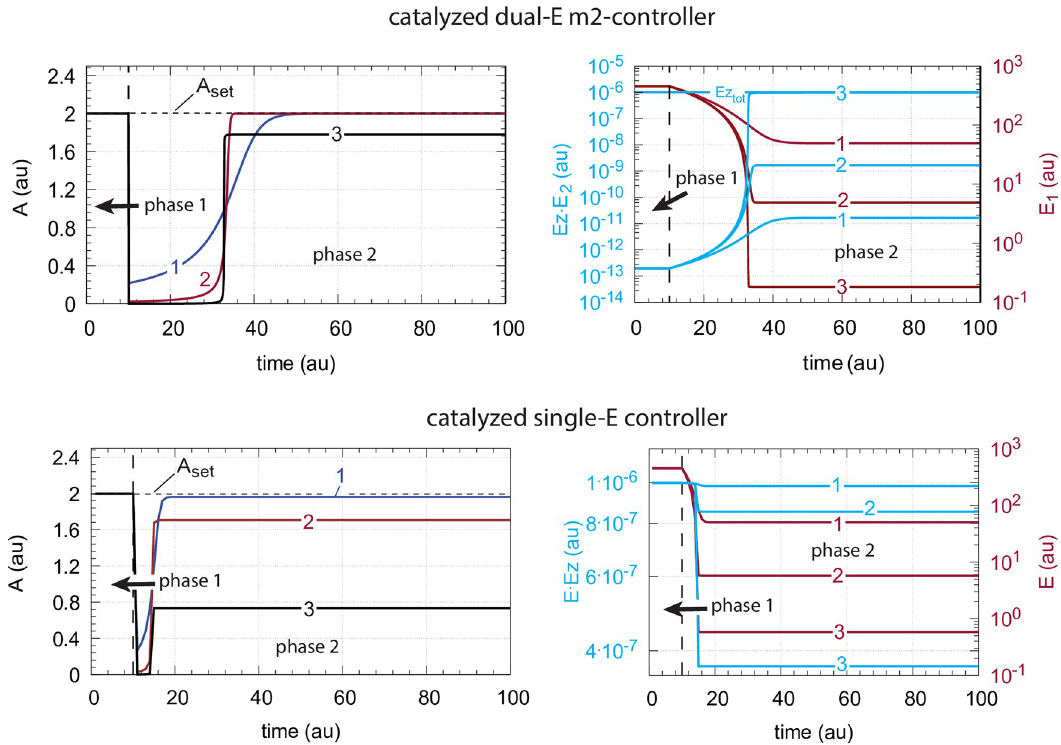
Fig 7. Behavior of the catalyzed dual-E controller (Fig 5) and the single-E controller (Fig 6) towards step-wise perturbations in k 2 . Total enzyme concentration Ez tot =1 × 10 − 6 . Upper left panel: Behavior of controlled variable A of the dual-E controller. Phase 1: k 2 =10.0; phase 2: 1 , k 2 = 1 × 10 2 ; 2 , k 2 = 1 × 10 3 ; 3 , k 2 = 2 × 10 4 , note the offset in A from A set . Upper right panel: Behavior of E 1 and Ez � E 2 as a function of k 2 -perturbations 1–3. Note that for perturbation 3 the enzyme is saturated with E 2 . Rate constants: k 1 =0.0,